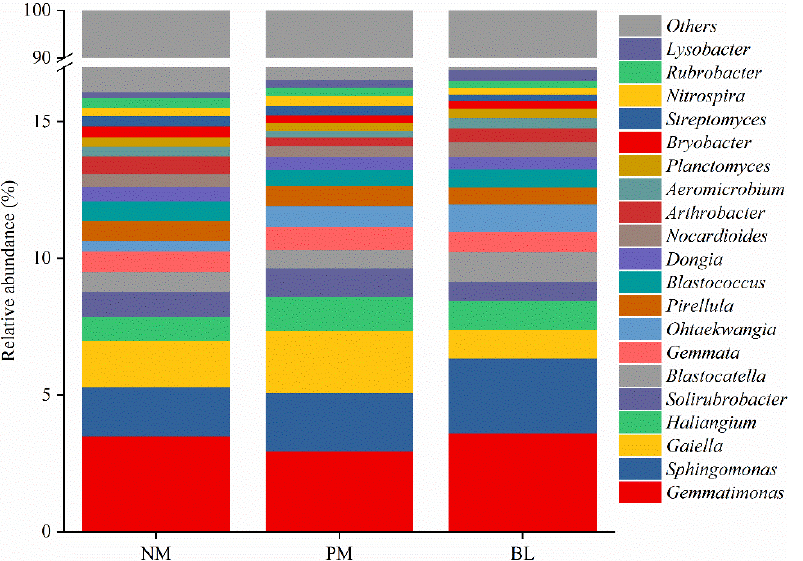
Figure 3. Percent distribution of soil bacterial genera in the three treatments. NM: non-mulched spring maize (control); PM: plastic-mulched spring maize; BL: bareland fallow. n = 3 (NM, PM, BL).